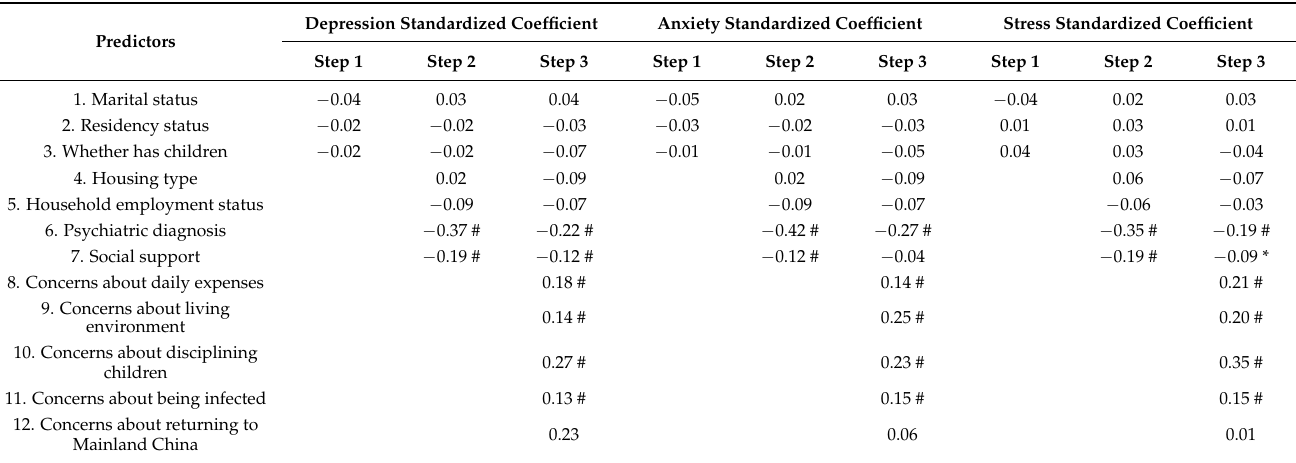
Table 5. Regression